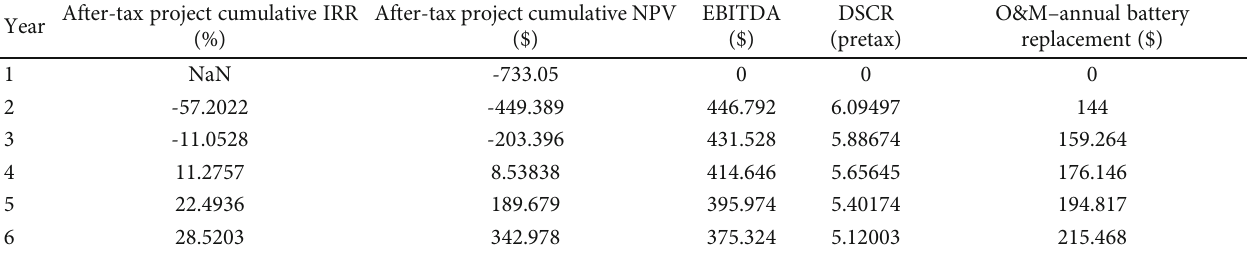
Table 2: Financial model critical metric